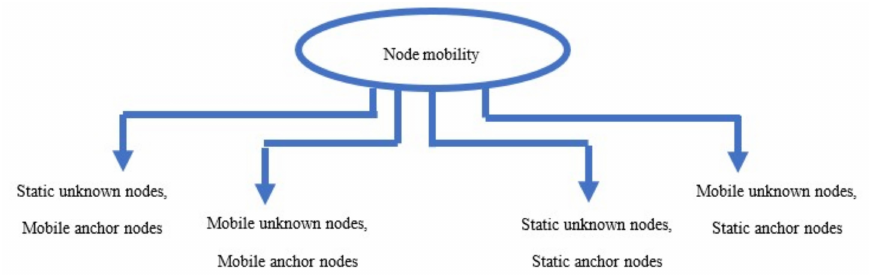
Figure 1. Classification of node mobility.